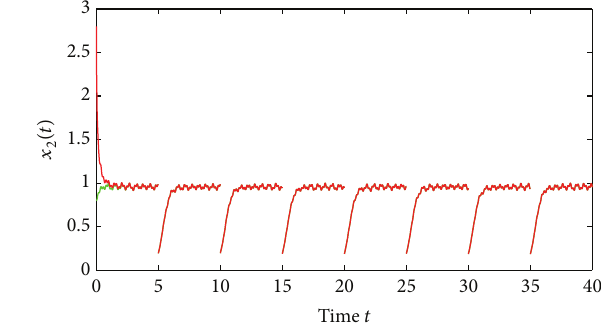
Figure 1: State variable 𝑥 1 of Example 1.